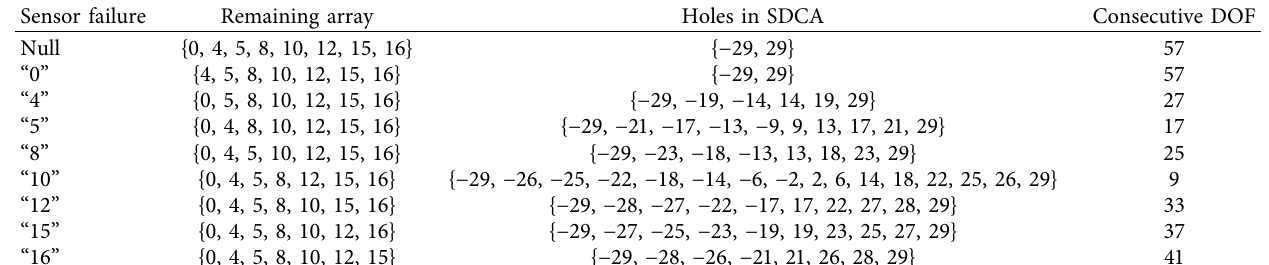
Table 3: The array robustness to sensor failure.